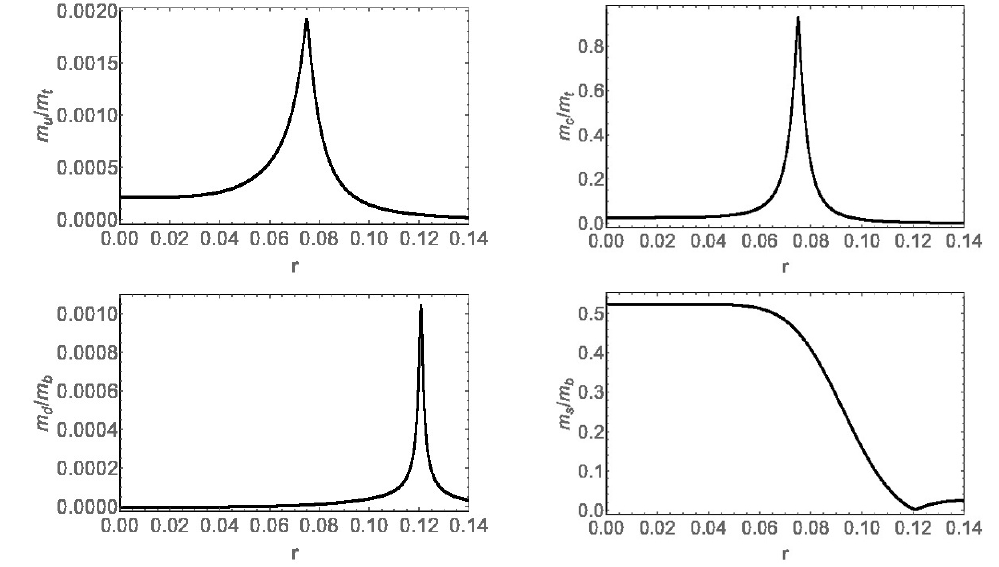
Figure 4 . The blow-up radius ( r )-dependence of the mass ratios of the up quark to the top quark m u =m t , the charm quark to the top quark m c =m t , the down quark to the bottom quark m d =m b , and the strange quark to the bottom quark m s =m b